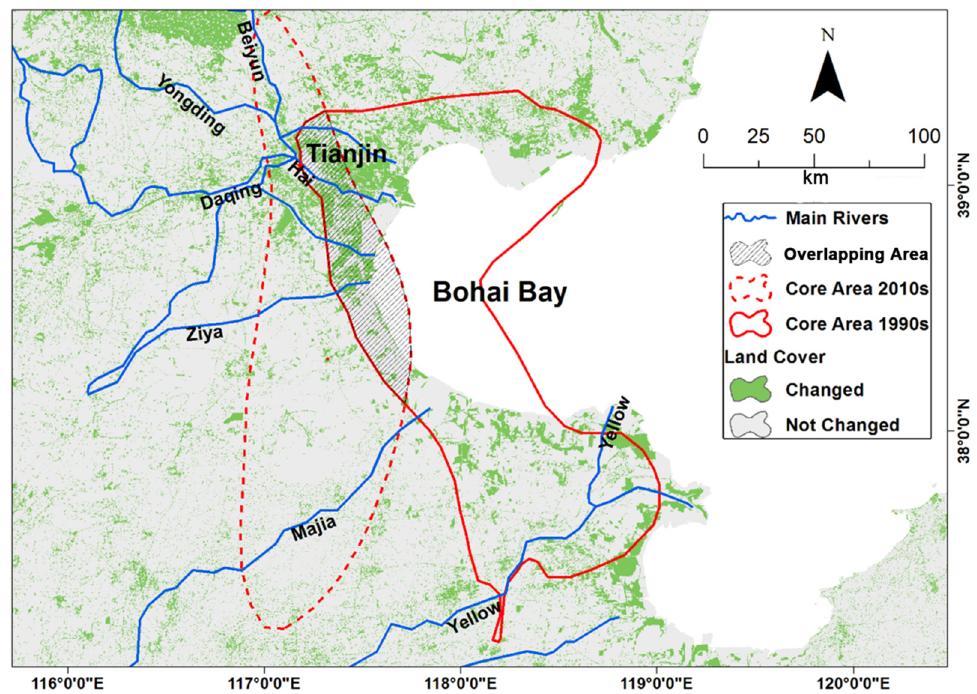
Figure 2. Map shows the small overlap (grey shaded area) of stopover sites between the migratory paths during the early 2010s (dashed red line) and early 1990s (solid red line) in the vicinity of Tianjin, the largest city on the shore of Bohai Bay. The background is the landcover changes (green) between 1990 and 2010. Table 4. Landcover (ha) within the early Beidaihe migratory path.